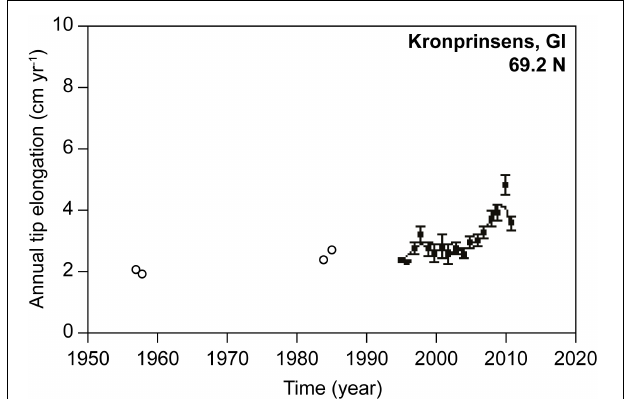
FIGURE 3 | Time series of Ascophyllum nodosum tip growth at Kronprinsens Ejland, Disko Bay, Greenland (69 ◦ N). Circles represent growth observations and solid lines 3-year running means. Data from 1957–1958 and 1984–1985 are shown with open circles while more recent data are shown with filled circles. Adapted from Marbà et al. (2017) (http://creativecommons.org/licenses/by/4.0/).